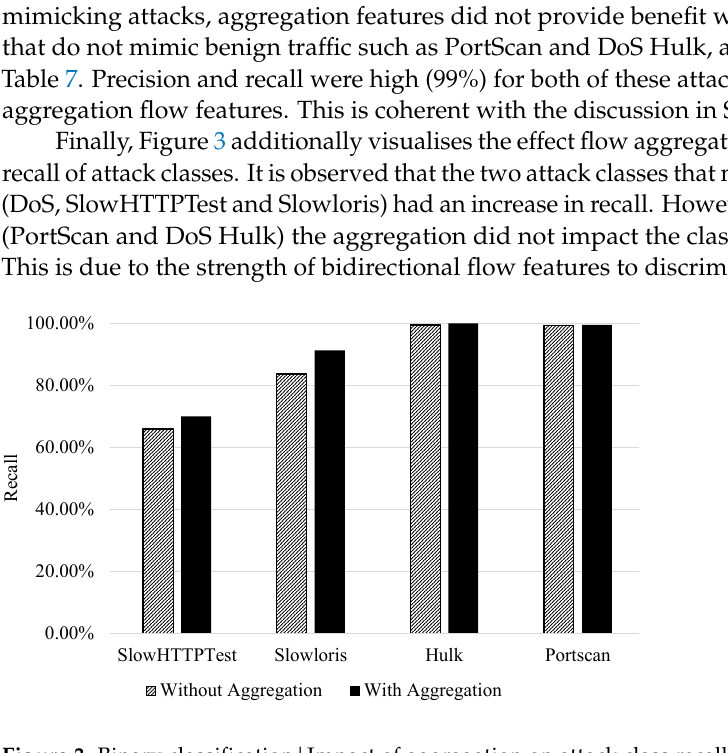
Figure 3. Binary classification|Impact of aggregation on attack class recall (benign vs. attack classifi-